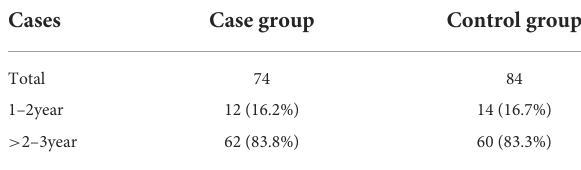
TABLE 1 Demographical factors of the case group and the control group.